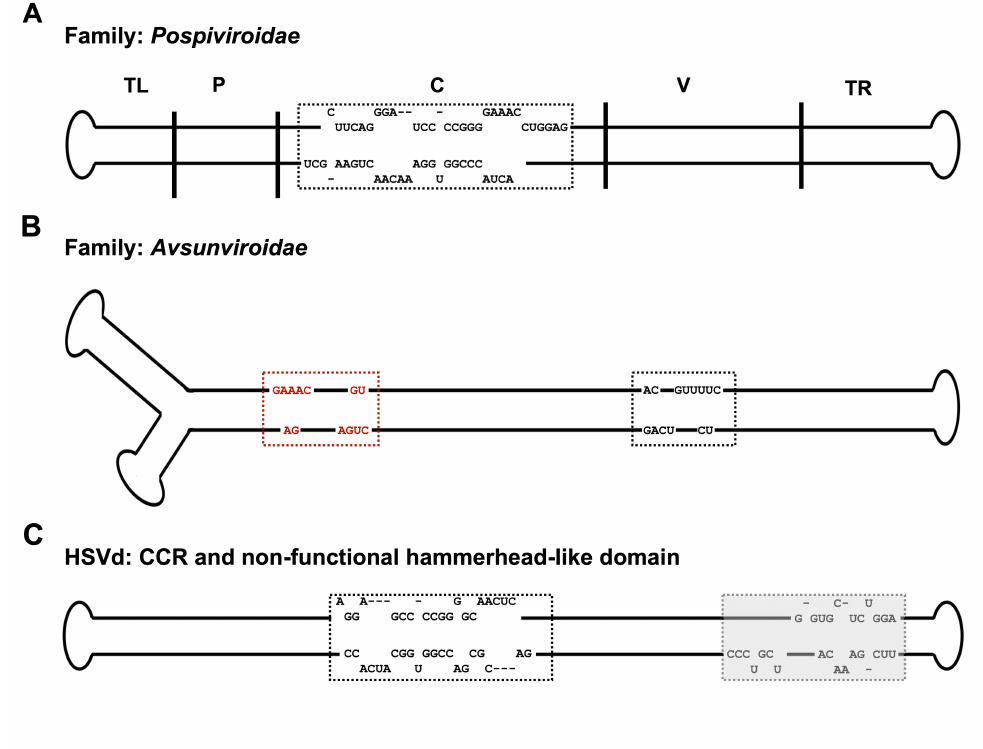
Figure 2. Primaryandsecondarystructuralfeaturesusedforviroidclassification. Schematicrepresentations of ( A ) The rod-like secondary structure of potato spindle tuber viroid (PSTVd). The five functional domains are shown on the secondary structure of PSTVd: The Terminal left (TL), Pathogenicity (P), Central (C), Variable (V), and Terminal right (TR) domains are delimited by the vertical solid lines and are named accordingly. The sequence of the central conserved region (CCR), which is the characteristic feature of the members of the family Pospiviroidae , is indicated within the box. ( B ) The branched secondary structure of avocado sunblotch viroid (ASBVd). The conserved nucleotides of the hammerhead’s catalytic core, the characteristic feature of the members of the family Avsunviroidae , are boxed. The sequences within the red and black boxes denote the hammerhead self-cleaving motifs formed in the viroid’s ( + ) and ( − ) strands, respectively. ( C ) The rod-like secondary structure of hop stunt viroid (HSVd) showing both the CCR (black color boxed) and a non-functional hammerhead-like domain (shadowed box),